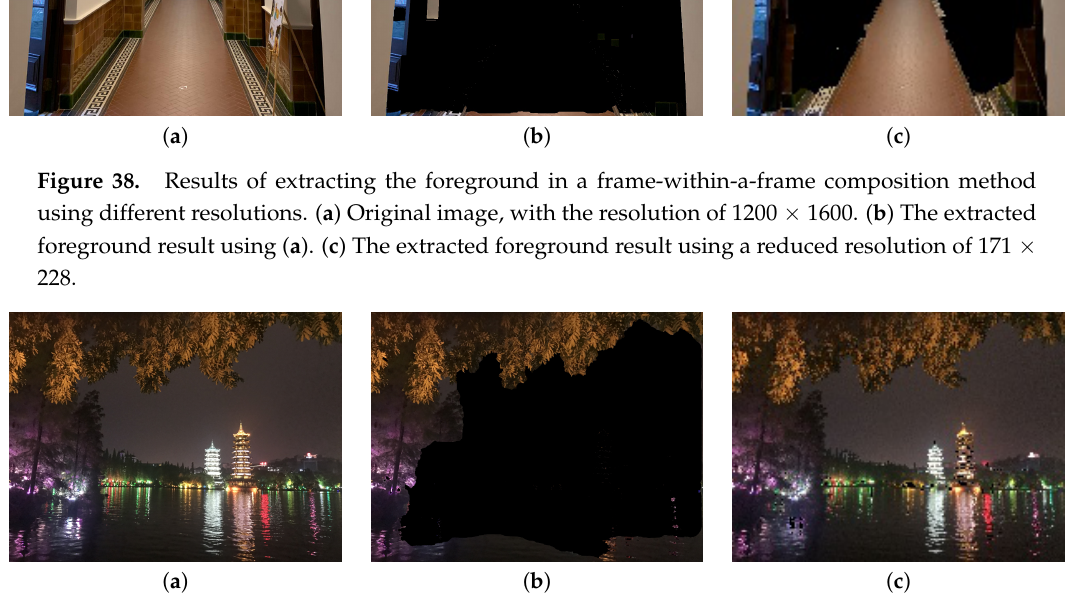
Figure 39. Results of extracting the foreground in a frame-within-a-frame composition method using different resolutions. ( a ) Original image, with the resolution of 4032 × 3024. ( b ) The extracted foreground result using ( a ). ( c ) The extracted foreground result using a reduced resolution of 201 ×